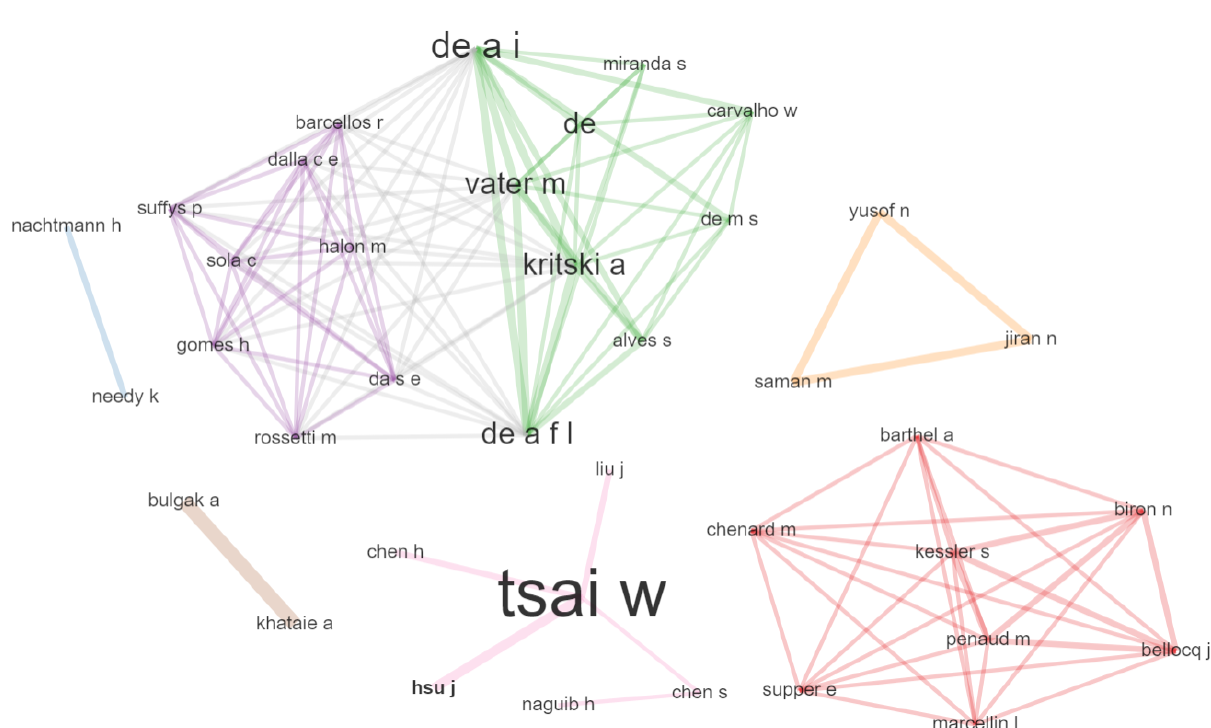
Figure 7. Countries network.